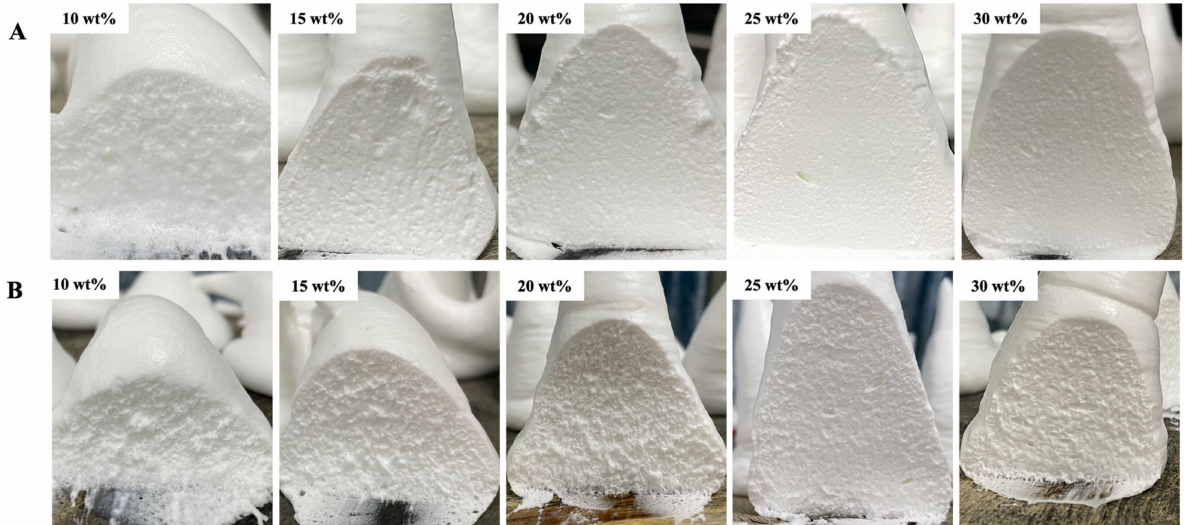
Figure 8. The images of cross-sections of whipped creams at different sugar concentrations. ( A , B ) represent the images of cross-sections of whipped creams with glucose ( A ) and corn syrup ( B ) after 6 h